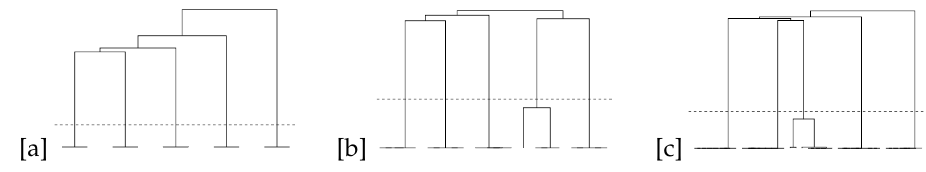
Figure 8. Dendrograms for the complete schools dataset. Coordinates of each cluster prototype are represented with respect to the x-axis.